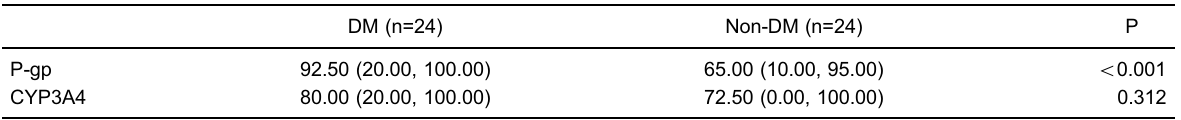
Figure 1. Hematoxylin and eosin staining of duodenum tissues from patients with pancreatic cancer with ( A and B ) or without ( C and D ) diabetes mellitus. Representative images are shown. Magni fi cation 100 (cid:1) ( A and C , scale bar 100 m m) and 200 (cid:1) ( B and D , scale bar 50 m m). Table 2. Duodenal expression score (1 – 100) of CYP3A4 and P-gp proteins in patients with pancreatic cancer with or without diabetes mellitus